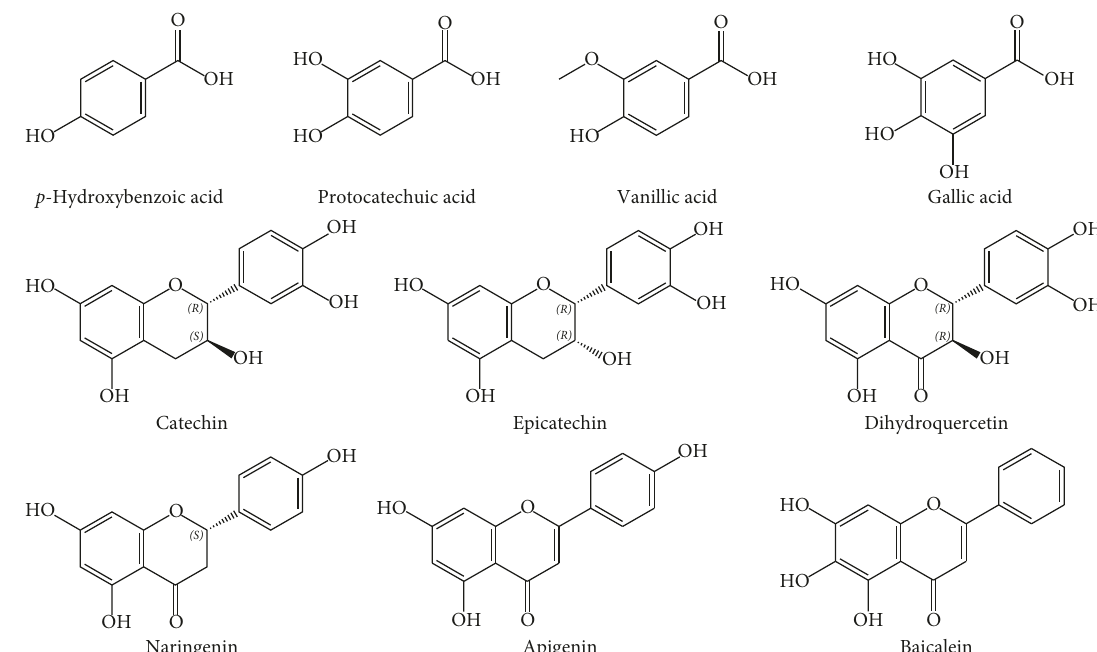
Figure 1: The chemical structures of ten investigated phenolic